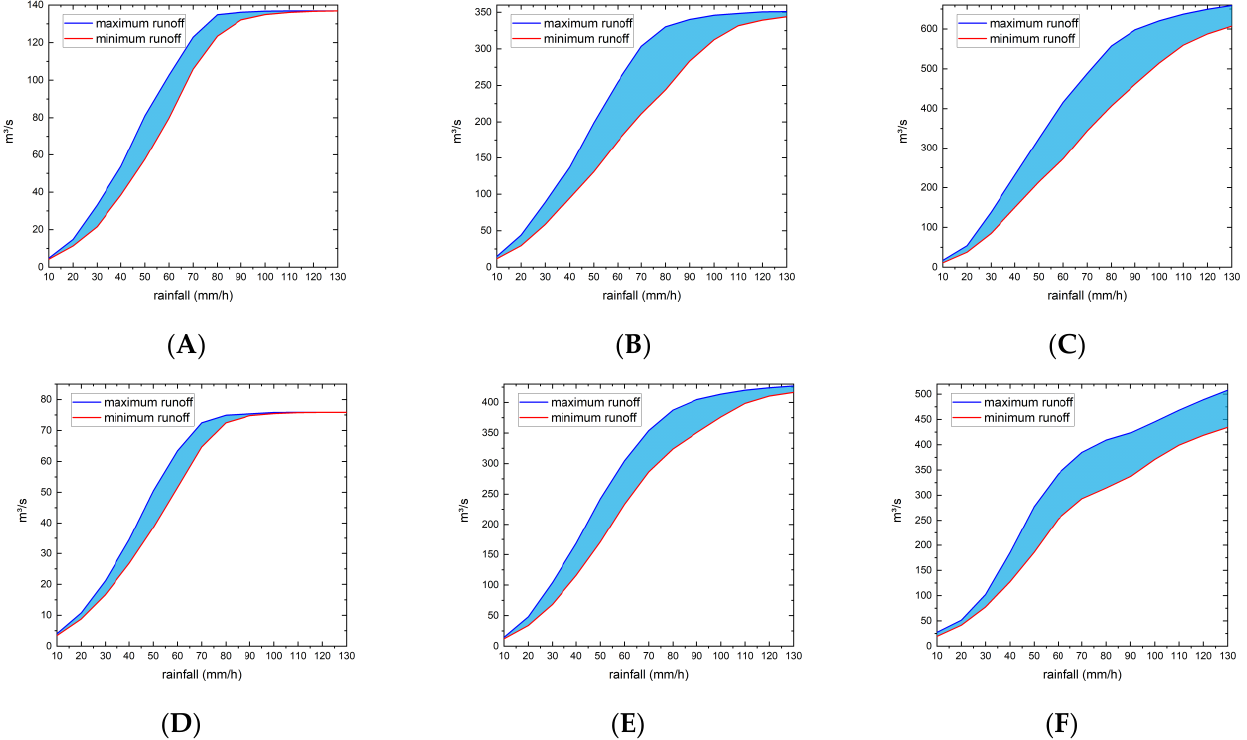
Figure 7. The peak runoff ranges with the same rainfall intensity (RI) value but different RMDs for 6 river sections. ( A ), section 50 of the Dasha River. ( B ), section 100 of the Dasha River. ( C ), section 150 of the Dasha River. ( D ), section 30 of the Buji River. ( E ), section 80 of the Buji River. ( F ), section 130 of the Buji River.